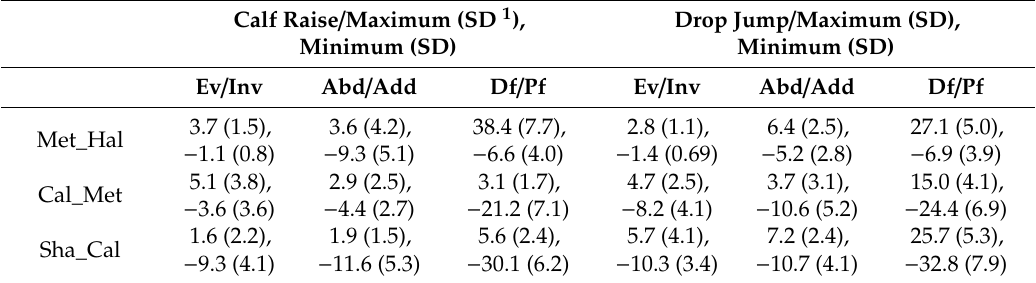
Drop Jump / Maximum